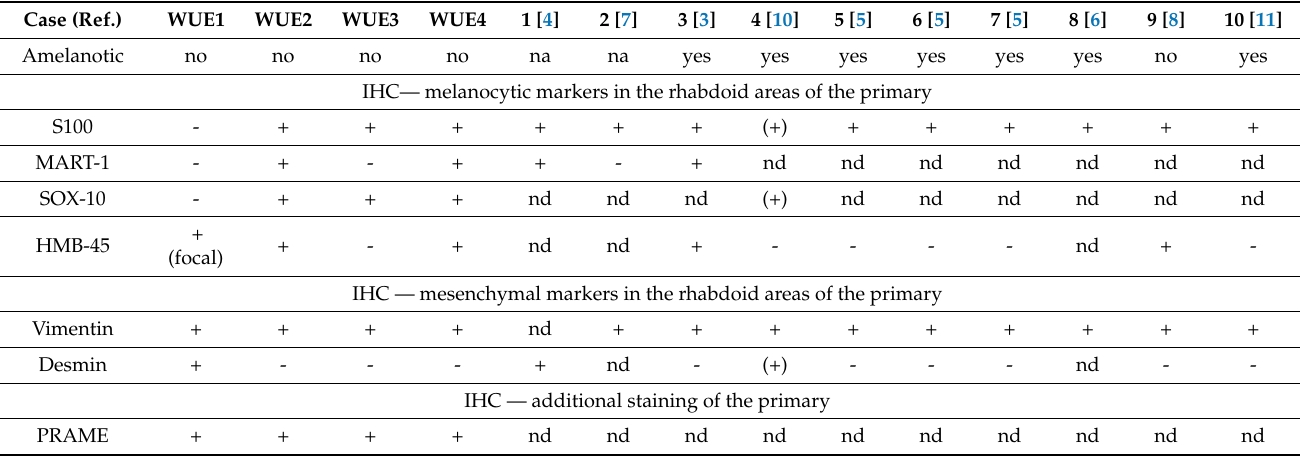
Table 3. Immunohistochemical patterns of rhabdoid differentiated primary